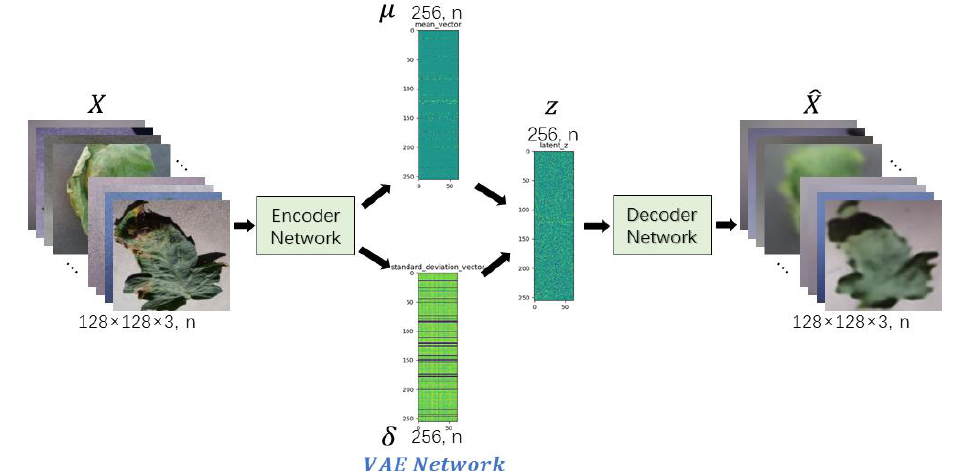
Figure 1. Structure of the VAE